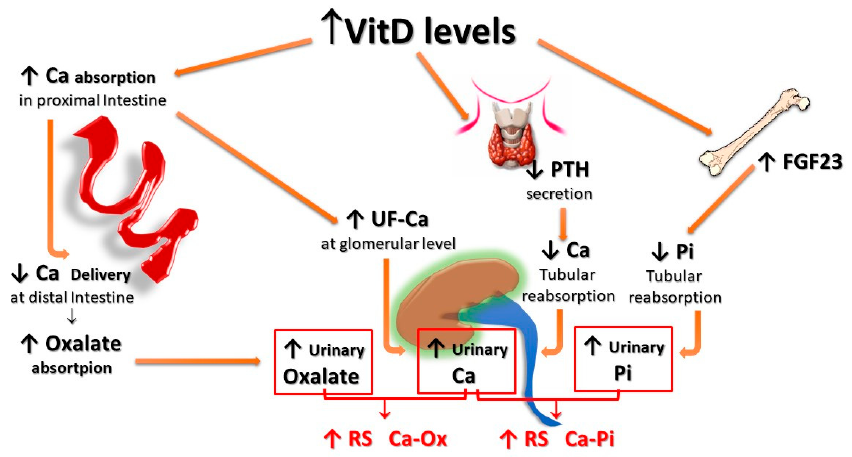
Figure 3. Potential effects of vitamin D supplementation on UL risk. Vitamin D stimulates active calcium transport, mainly in the proximal intestine, inducing HC even with calcium intake within the normal range; since less calcium reaches the distal gut, an increased amount of oxalate remains free for being absorbed in the distal tract; vitamin D also inhibits PTH production and stimulates FGF-23 production by osteocytes, with a resulting decrease of calcium and phosphate tubular reabsorption, respectively. All these effects translate into an increase in both the relative urinary supersaturations of calcium oxalate and calcium phosphate. FGF-23 : Fibroblast Growth Factor-23; F-Ca : filtered Calcium; HC : Hypercalciuria; PTH : Parathyroid